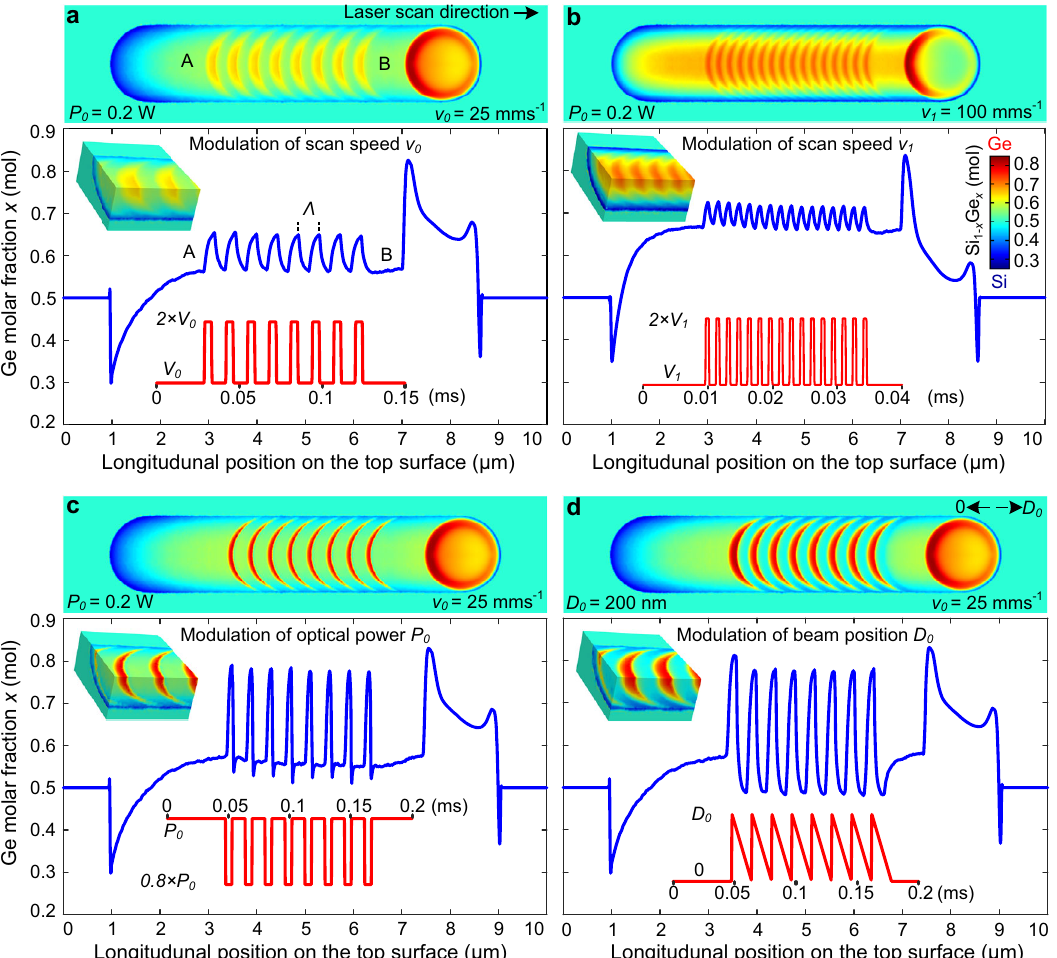
Fig. 6 Laser-written in-plane transverse SiGe superlattices fabricated by sub-millisecond modulation of the scan speed, optical power, and beam position. Composition color maps show the Ge molar fraction x on the top surface of the laser-written microstripes. Inset fi gures show the periodic composition distributions at the transverse and longitudinal cross-sections to reveal the depth of the modulated regions. Modulated laser processing parameters and resulting composition pro fi les on the top surface are given in red and blue colors, respectively. All square wave modulations have a duty cycle of 1/3. a A 77.6 kHz square wave modulation of the stage scan speed v between 25 – 50 mm s − 1 results in an in-plane SiGe superlattice with a period of Λ = 430 nm. b 621.1 kHz modulation of the stage scan speed v between 100 – 200 mm s − 1 forms a SiGe superlattice with a period of Λ = 220 nm. c While the stage moves at a constant speed of 25 mm s − 1 , 61.0 kHz 20% modulation (reduction) of the laser power P 0 = 0.2 W forms a SiGe superlattice with a period of Λ = 402 nm. d 61.1 kHz sawtooth wave modulation of the beam position with a back-and-forth movement of 200 nm forms a SiGe superlattice with a period of Λ = 410 nm. The color scale applies to all composition